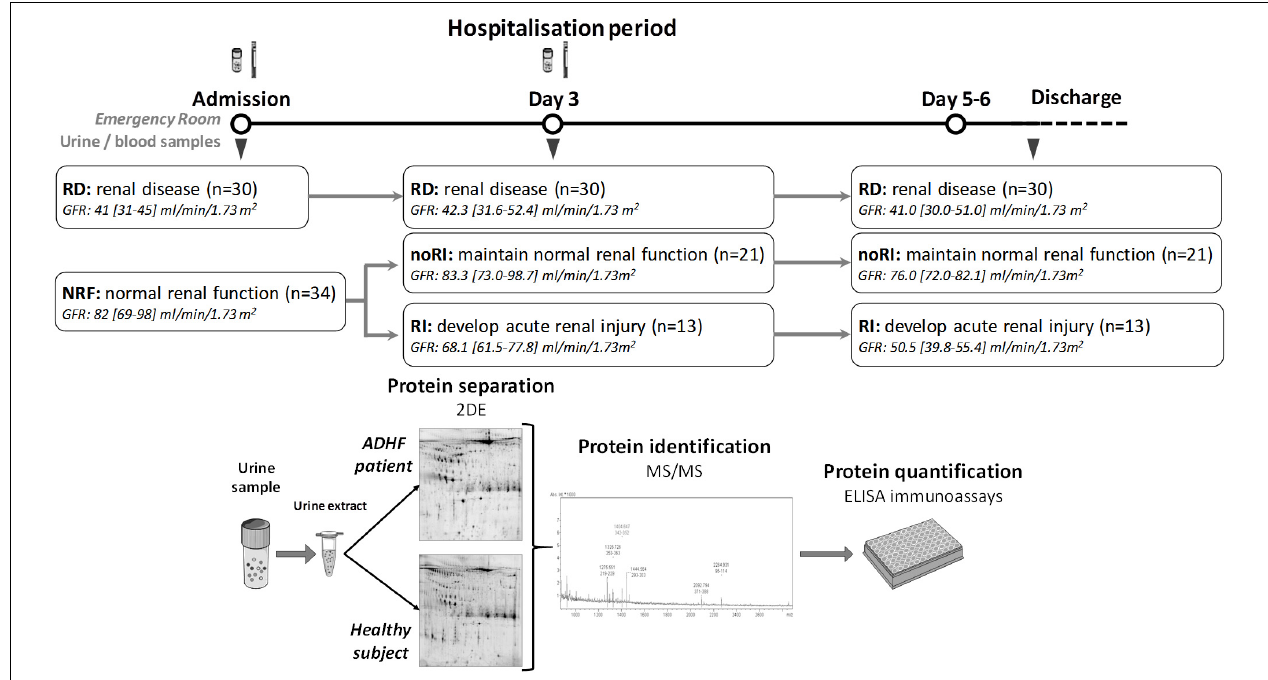
FIGURE 1 | Study design. Patients with ADHF were divided in two groups at hospital admission depending on their glomerular filtration rate. RD group included patients with glomerular filtration rate < 60 ml/min/1.73 m 2 , while NRF presented glomerular filtration rate above this cutoff. At day 3, patients with NRF were divided in two groups depending on their kidney function evolution. RI patients developed renal function deterioration defined by glomerular filtration rate < 60 ml/min/1.73 m 2 , while noRI patients maintained normal glomerular filtration rate. Urine and blood samples were obtained at hospital admission and at day 3 of hospitalisation. Protein extracts from urine were prepared, and samples were analysed by two-dimensional (2DE)-electrophoresis and mass spectrometry for identification of differential protein patterns. Validation studies were performed by ELISA. Sample size is given in